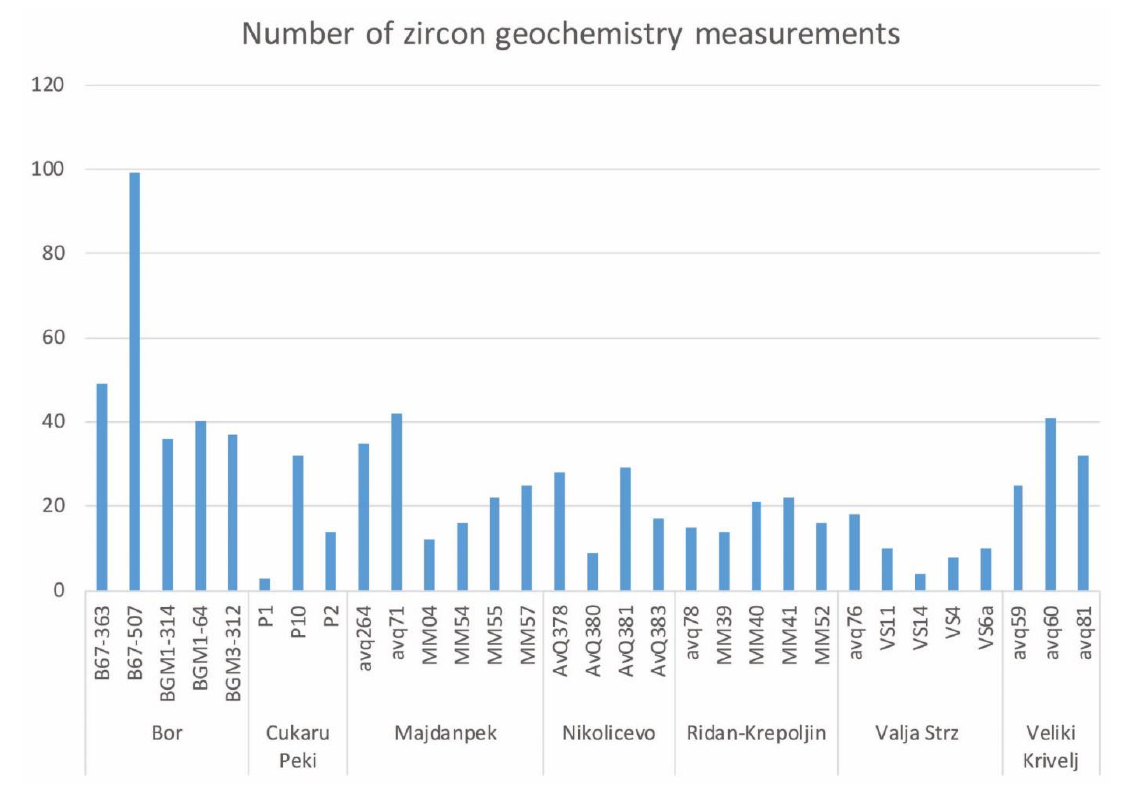
Figure 16. Number of data points for each sample and deposit.